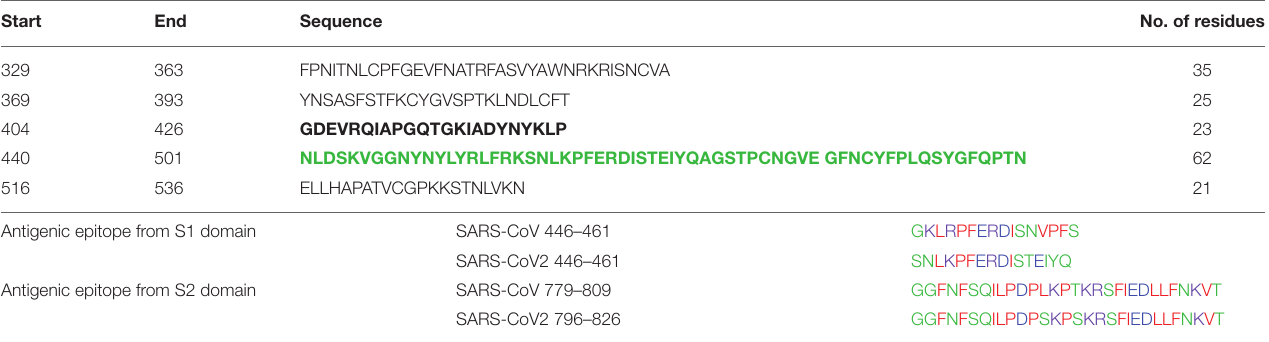
TABLE 3 | Antigenic epitopes from spike protein of SARS-CoV in comparison with SARS-CoV-2 of spike protein. Start End Sequence